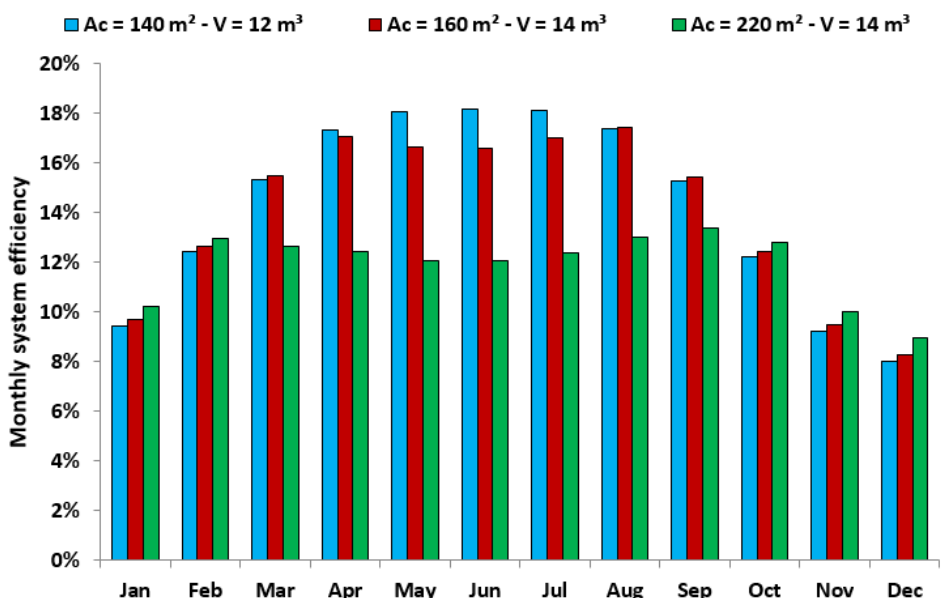
Figure 10. Monthly system efficiency for optimum cases ( A c = 140 m 2 – V =12 m 3 , A c = 160 m 2 – V = 14 m 3 , A c = 220 m 2 – V = 14 m 3 ).